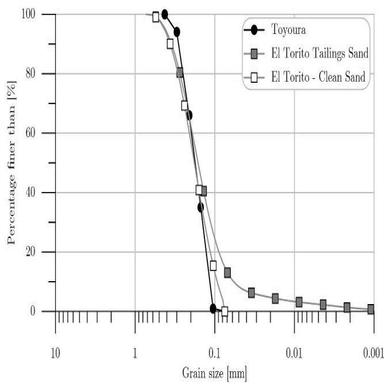
Particle size distribution for Toyoura sand, the El Torito tailings sand and clean fraction.